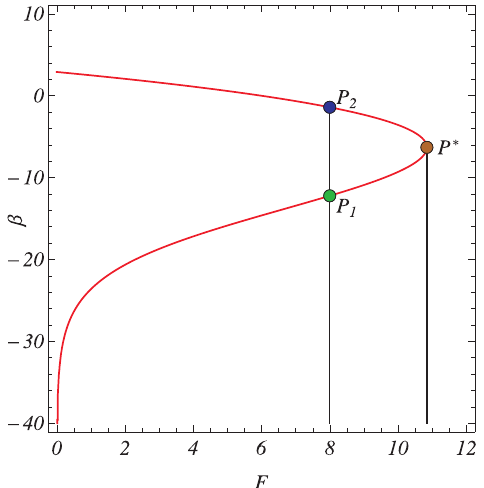
Figure 2. The curve Γ R for R = 0.5.